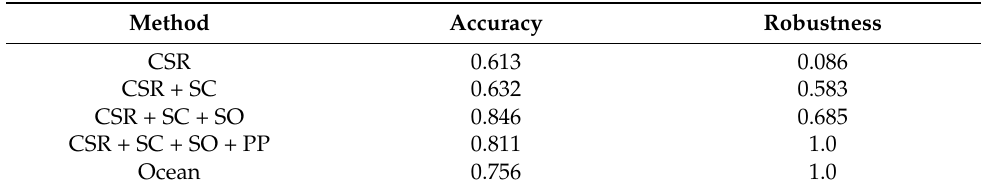
Table 2. Tracking performance comparison.